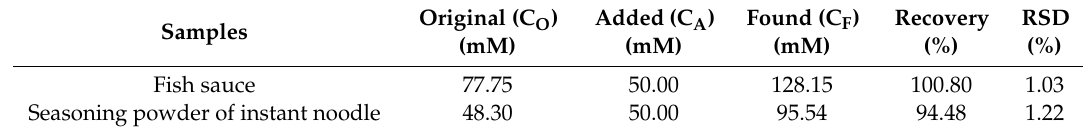
Table 1. Determination of sodium in real sample.